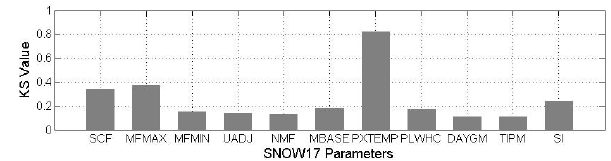
Fig. 5. Kolmogorov-Smirnov ( KS ) values for SNOW17 parameters for the upper